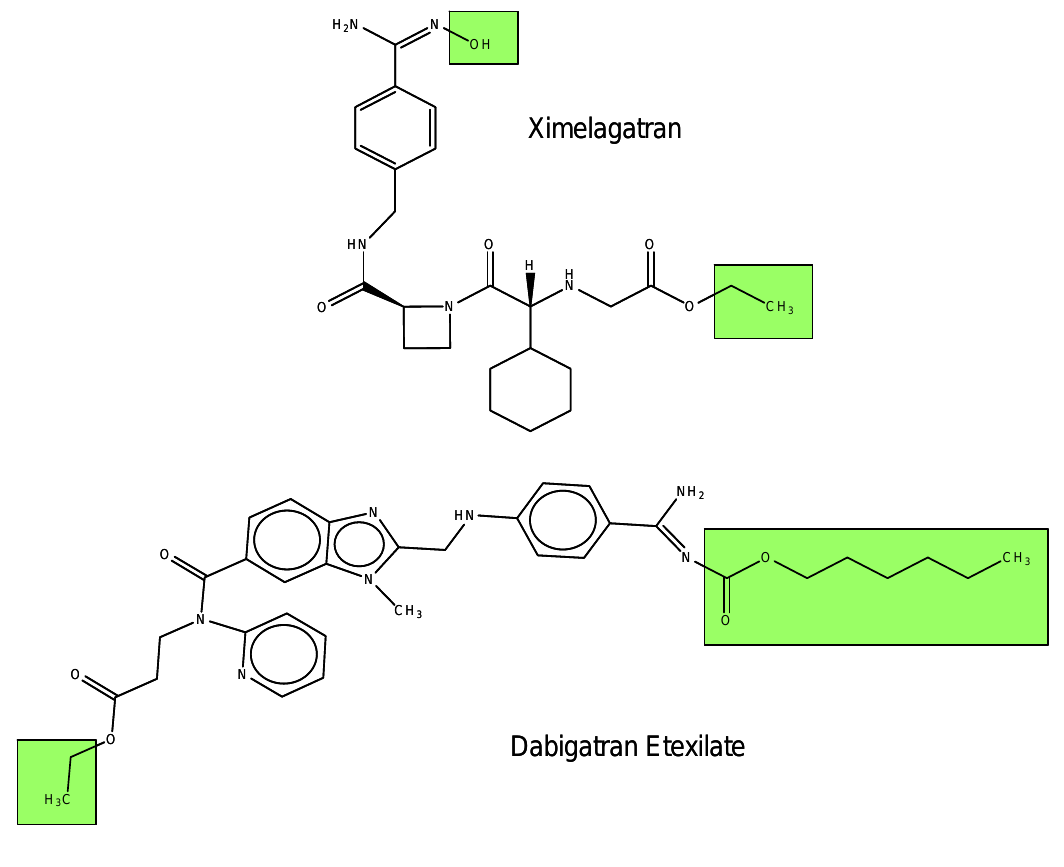
Figure 2. Chemical structures of Ximelagatran and Dabigatran Etexilate [11]